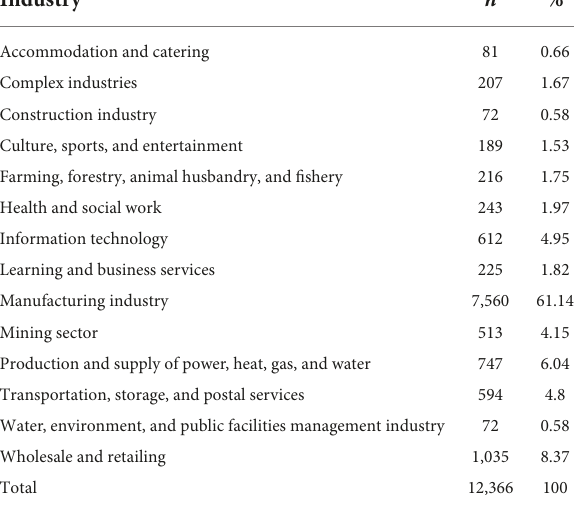
TABLE 1 Industrial distribution of